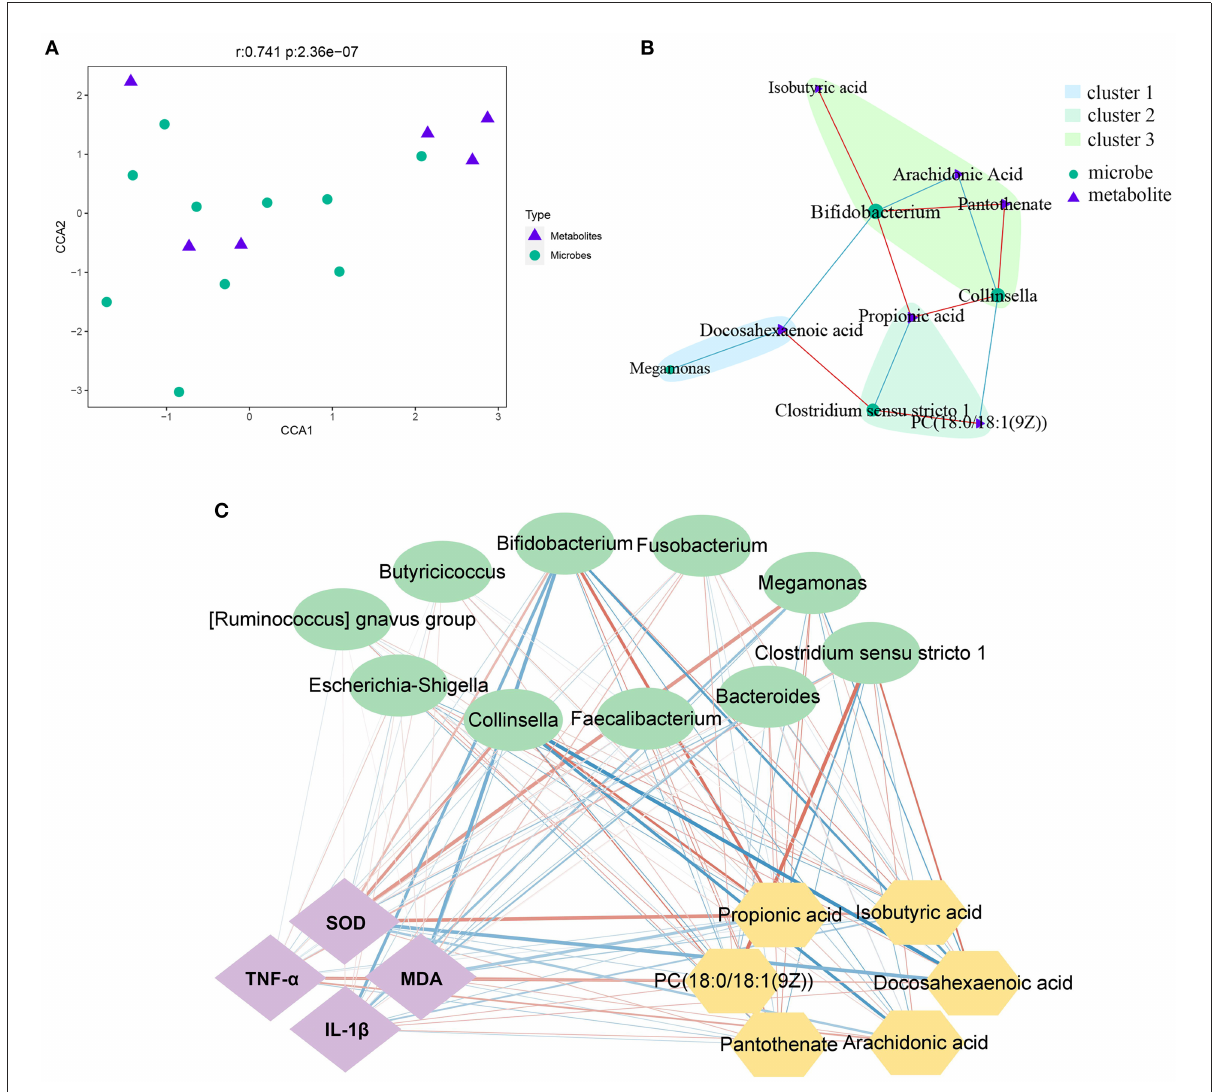
FIGURE5 Correlation analysis between microbes and metabolites. (A, B) The canonical correlation analysis (CCA) and the pair correlation analysis between metabolites and microbiota. (C) The interaction network among phenotype index, bacteria and metabolites; the strength of the interaction is represented by the thickness and depth of the lines. The stronger the interaction, the thicker and darker a line is. The red line represents the positive relationship, and the blue line represents the negative relationship. MDA, malondialdehyde; SOD, superoxide